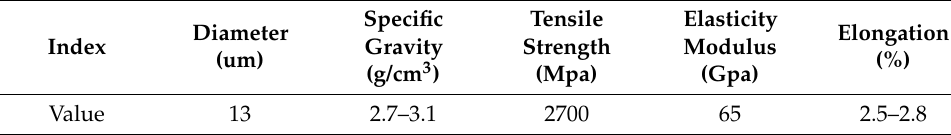
Figure 3. Basalt fiber. Table 1. Basic properties of basalt fiber.